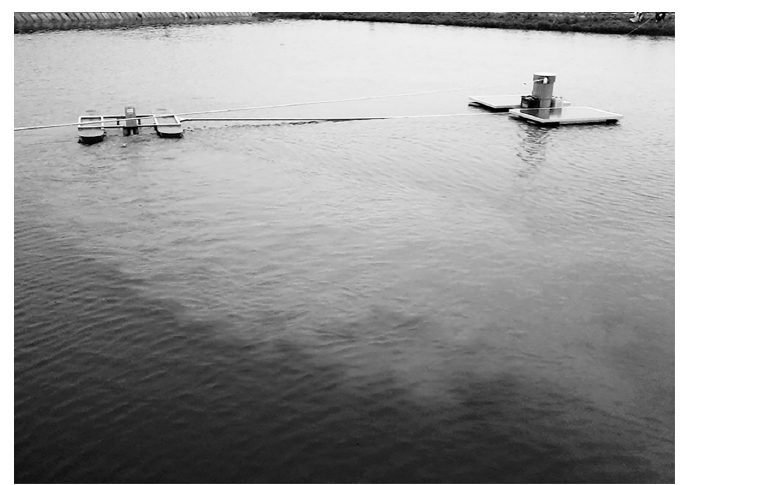
Fig 6. Performance of the SMWM.